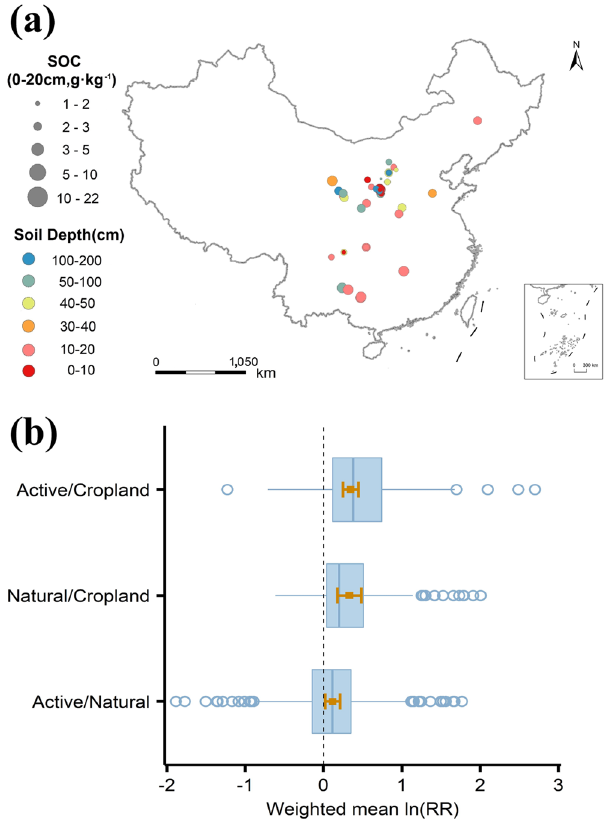
Fig. 1 Effects of active versus natural restoration on soil carbon sequestration across China. a Distribution map of restoration studies across China (drawing review No: GS(2016)2929); b Effects of active or natural restoration relative to cropland and those of active versus natural restoration on soil carbon sequestration. The orange bar indicates the mean effects {ln (response ratio)} with their 95% con fi dence interval (CI). If the 95% CI does not cover zero, it means a signi fi cant effect by ecosystem restoration. The light blue one is a box graph indicative of the data outliers, upper limit, third quantile, median, fi rst quantile, and lower limit. SOC background soil organic